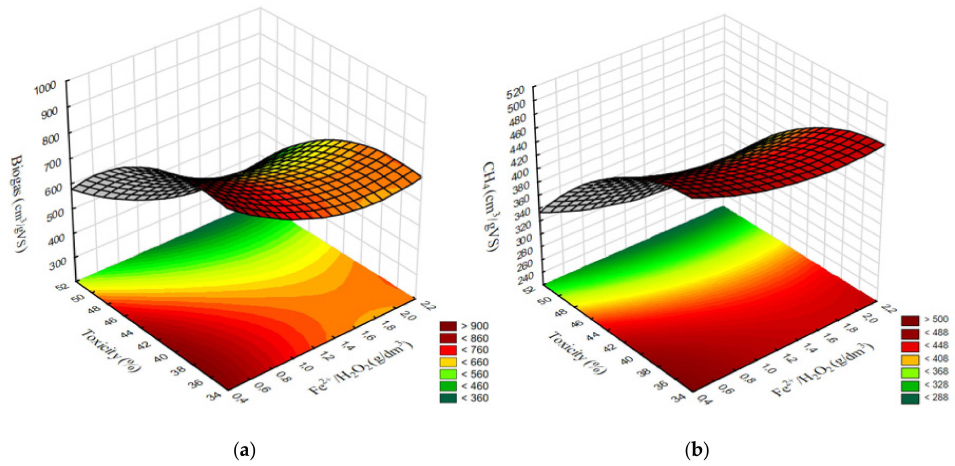
Figure 13. Predicted surface correlation between Fenton’s reagent dosage + toxicity and production of ( a ) biogas, ( b ) methane in series